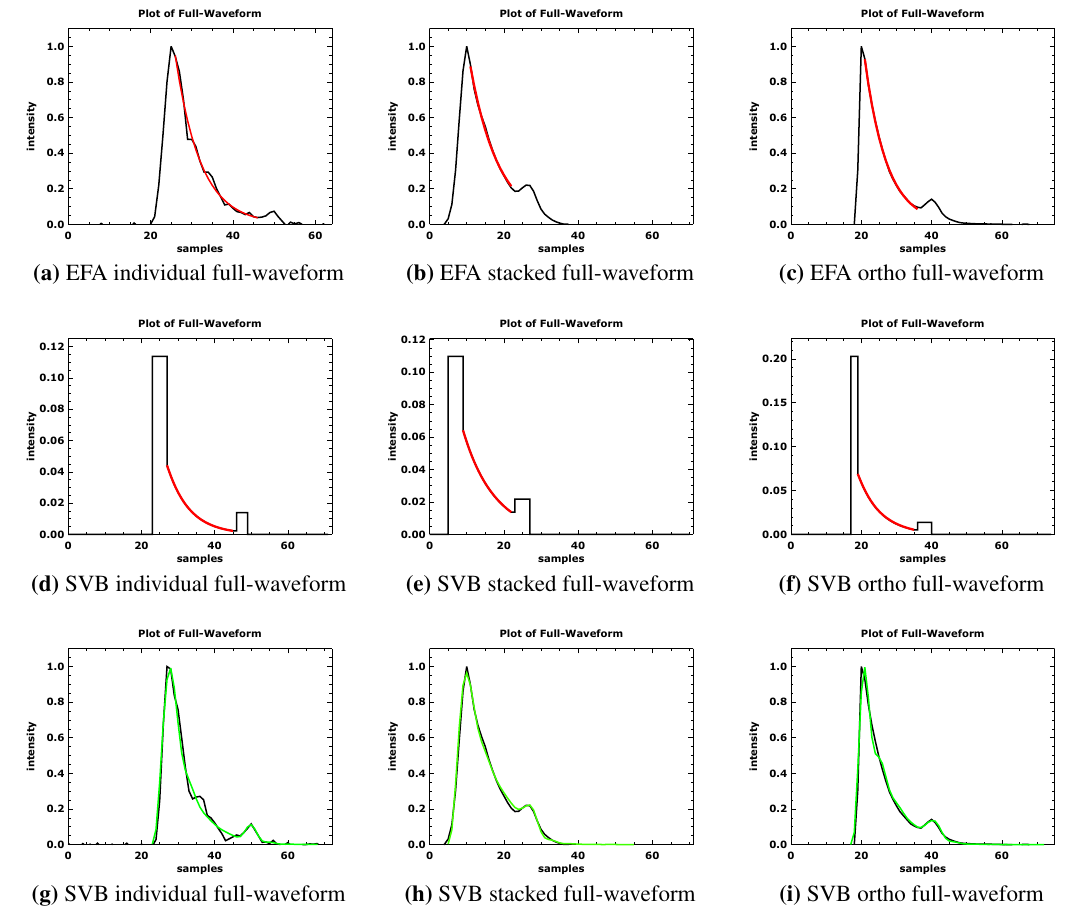
Figure 9. Turbidity estimation by exponential function approximation (EFA) and SVB algorithm (SVB); (a-c) full-waveform signal (black) and approximated exponential function (red); (d-f) dBCS model (black) and volume backscatter (red); (g-i) model of full-waveform signal (green) and full-waveform signal